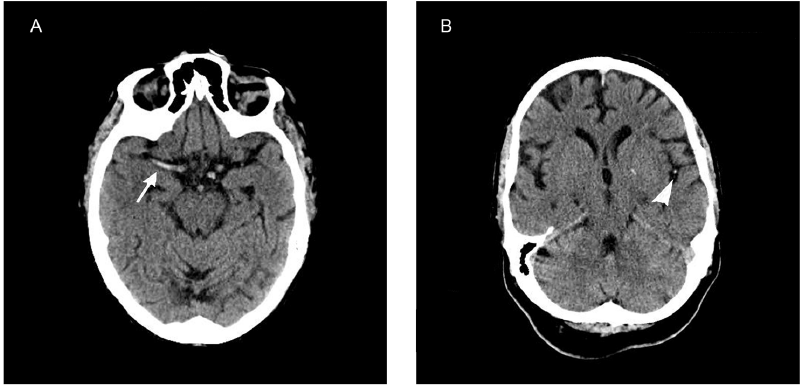
Figure 1. Hyperdense artery sign on noncontrast CT. (A) Transverse CT scan showing a proximal hyperdense artery sign (arrow) in the M1 segment of MCA. (B) Noncontrast CT showing a distal hyperdense artery sign in the sylvian fissure (arrowhead), which was also referred to as the MCA dot sign.